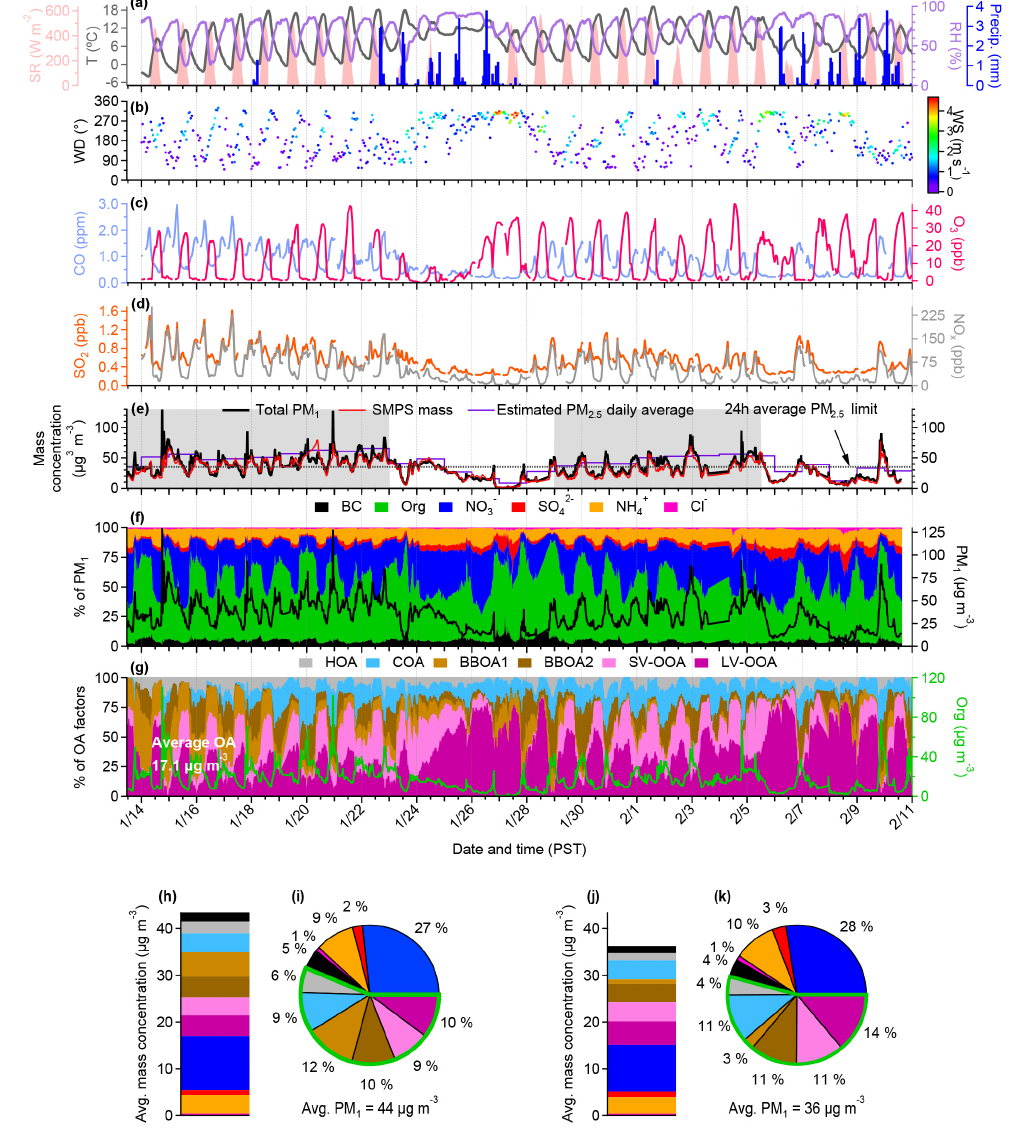
Figure 2. Overview of the chemical composition and temporal trends of submicron aerosols at Fresno in the San Joaquin Valley in January and February 2013 including (a) time series of ambient air temperature ( T ), relative humidity (RH), solar radiation (SR), and precipitation (Precip.); (b) time series of wind direction (WD) colored by wind speed (WS); (c) time series of gas-phase pollutants (CO and O 3 ) ; (d) time series of gas-phase pollutants (SO 2 and NO x ) ; (e) time series of total PM 1 and SMPS mass concentrations where SMPS mass was calculated using a time-varying density based on measured particle composition (see Fig. S1b). Also shown are the 24h average National Ambient Air Quality Standard for PM 2 . 5 (35µgm − 3 ) and the calculated average daily PM 2 . 5 concentrations for comparison. Persistent exceedances of this standard characterize the two pollution periods highlighted by gray shading (14–23 January and 29 January–5 February); (f) time series ) , sulfate (SO 2 − ) , ammonium (NH + ) , chloride (Cl − ) , and BC of the mass fractional contribution of organic aerosols (Org.), nitrate (NO − 3 4 4 to total PM 1 and time series of the total PM 1 concentration on the right axis; and (g) time series of the mass fractional contribution to total organic aerosol (OA) of the six factors derived from PMF analysis (see Sect. 3.2) and the time series of the organic aerosols. (h) Average mass concentration of the PM 1 species during the first polluted period. The organic aerosol fraction has been split into its components as derived from PMF analysis; (i) compositional pie chart of the PM 1 species from the first polluted period, where the total organic fraction is outlined in green; (j) average mass concentration of the PM 1 species during the second polluted period. The organic aerosol fraction has been split into its components as derived from PMF analysis; (k) compositional pie chart of the PM 1 species from the second polluted period, where the total organic fraction is outlined in